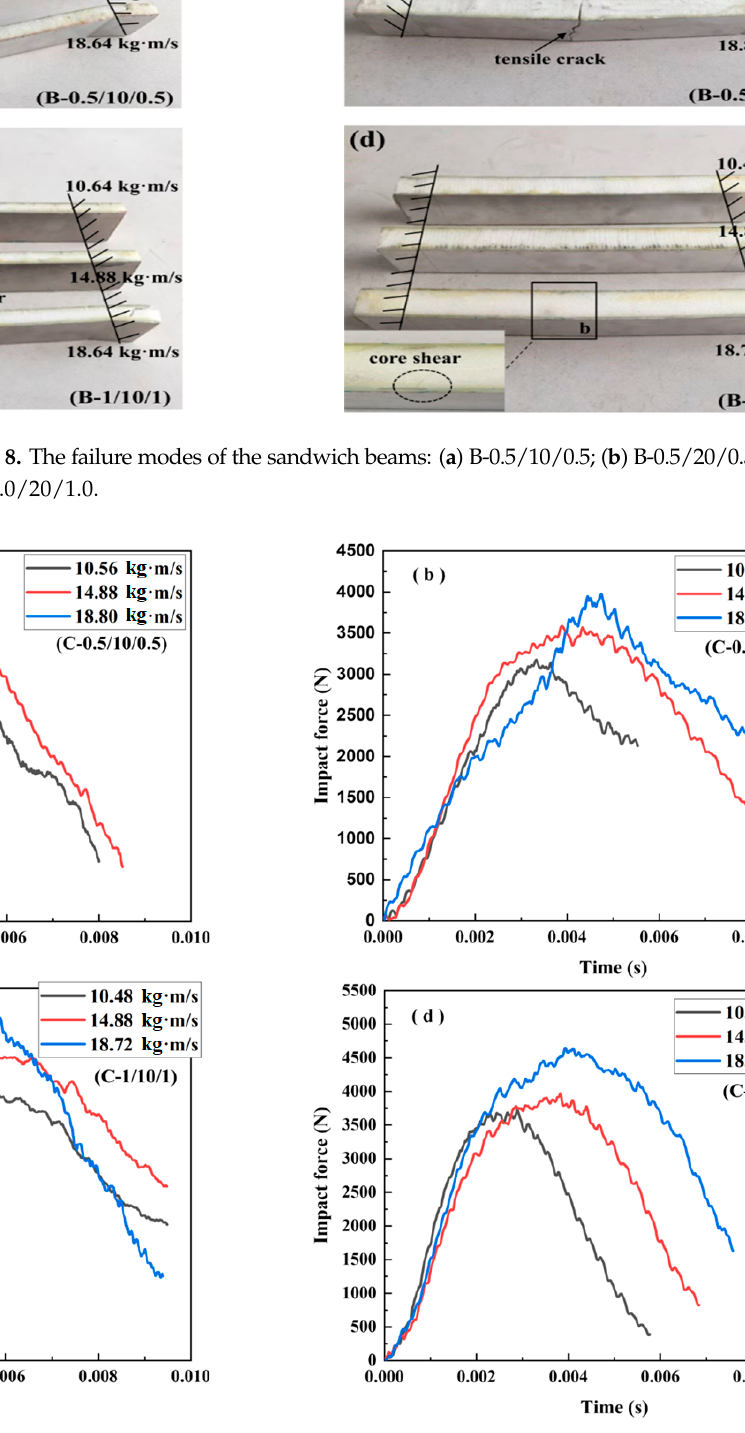
Figure 9. The impact force–time curve of the sandwich beams: ( a ) C-0.5/10/0.5; ( b ) C-0.5/20/0.5; ( c ) C-1.0/10/1.0; ( d ) C-1.0/20/1.0.